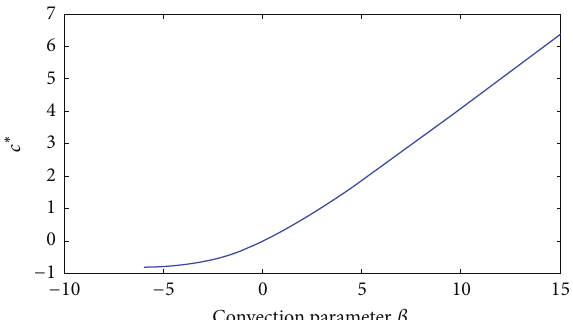
Figure 17: Plot of how 𝑐 ∗ changes with 𝑘 for ℎ 󸀠 (𝑢) = 𝛼 + 𝛾𝑢 , with 𝛼 = −1 < 0 . For a comparison, refer to Figure 10, where ℎ 󸀠 (𝑢) = 𝑘𝑢 .